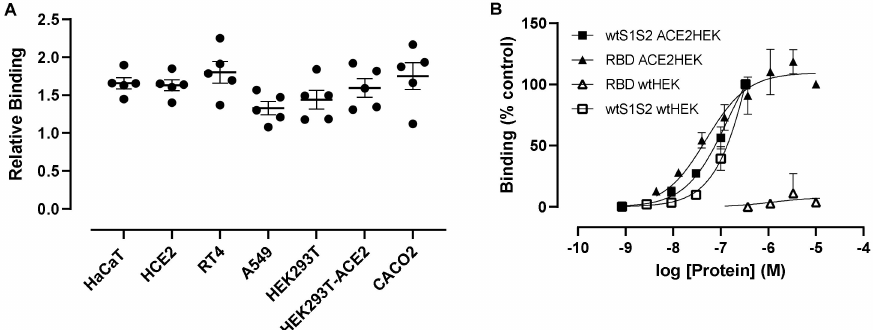
Figure 3. ACE2 is not required for wtS1S2 attachment to cells. ( A ) A549, wtHEK293, ACE2HEK293, Caco2, HaCaT, HCE2 and RT4 cells were incubated with 100 nM wtS1S2 for 60 min, before staining with anti-His6 secondary antibody labelled with Dylight 488. Binding of S1S2 attachment to various human cells. Data are calculated relative to the median fluorescence of secondary antibody alone (=1), means ± SEM from 5 separate experiments performed in duplicate. ( B ) Attachment of different concentrations of wtS1S2 (squares) or RBD (triangles) to wtHEK cells (open symbols) or ACE2HEK cells (filled symbols). Data are shown as a percentage of 10 µ M RBD binding to ACE2HEK cells, means ± SEM from 3 independent experiments performed in